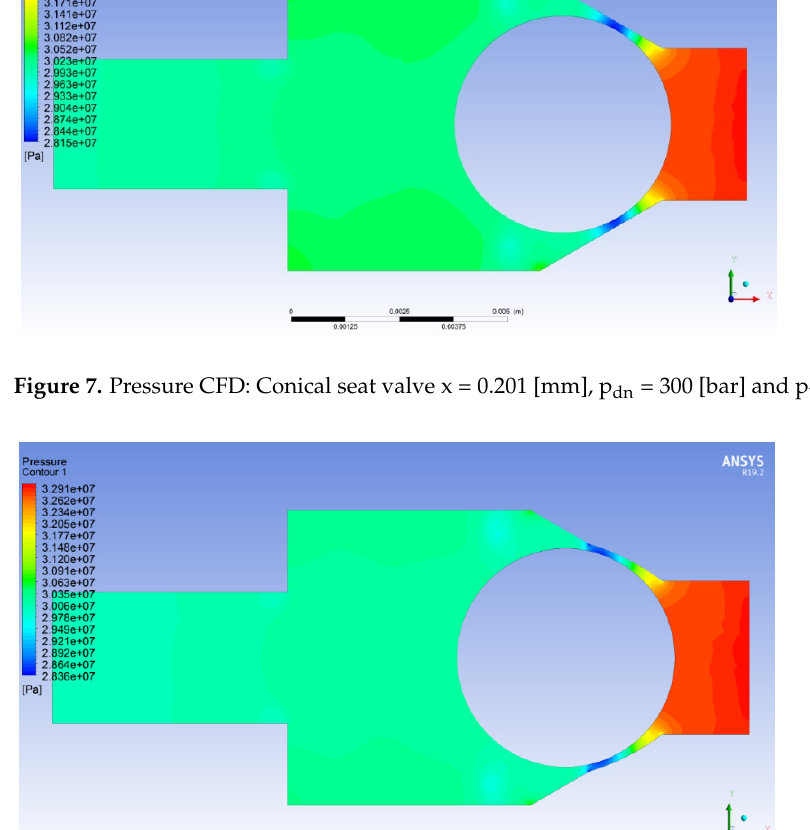
Figure 8. Pressure CFD: Spherical seat valve x = 0.201 [mm], pdn = 300 [bar] and pup = 330 [bar].